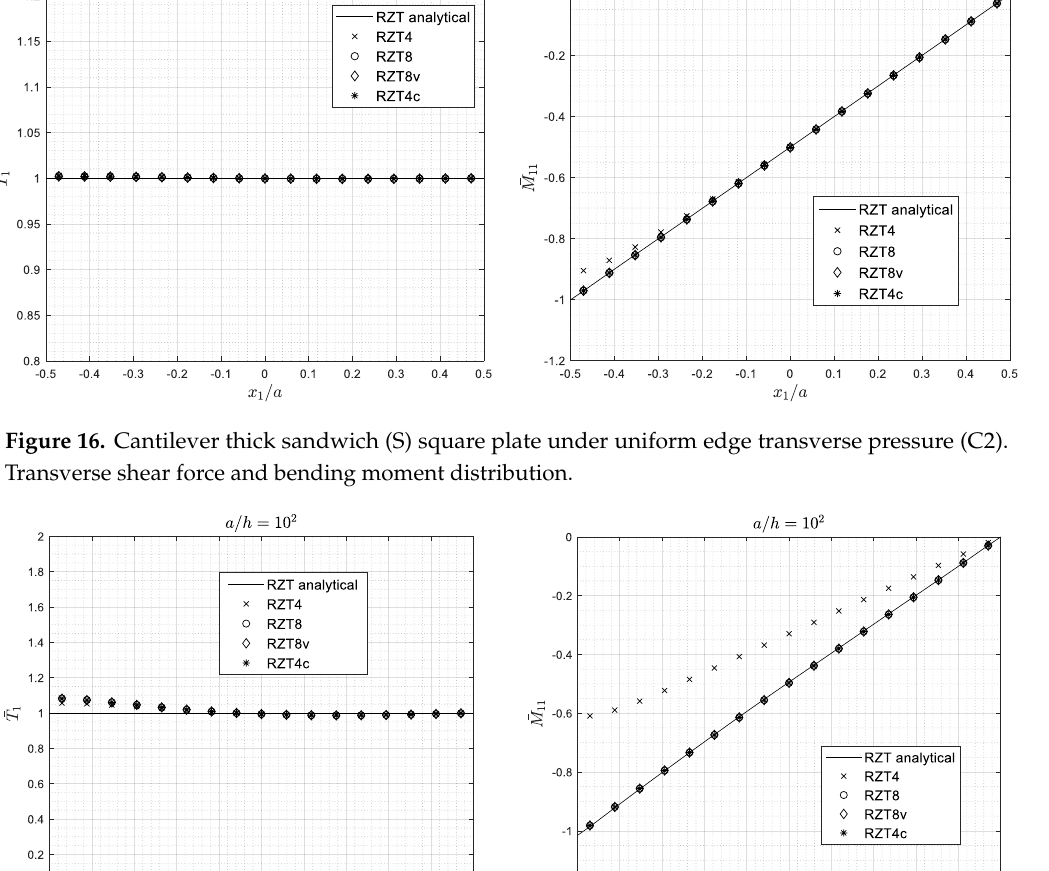
Figure 15. Cantilever thin sandwich (S) square plate under uniform transverse pressure (C1). Transverse shear force and bending moment distribution.